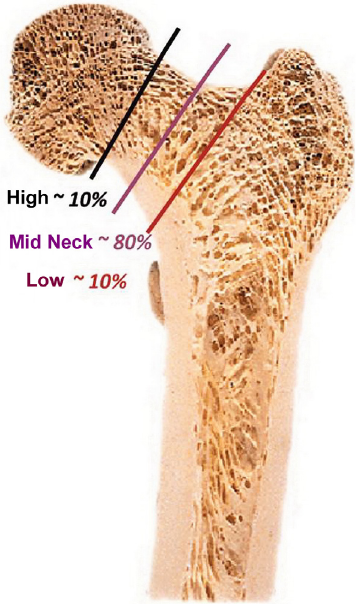
Figure 2. Resection levels with